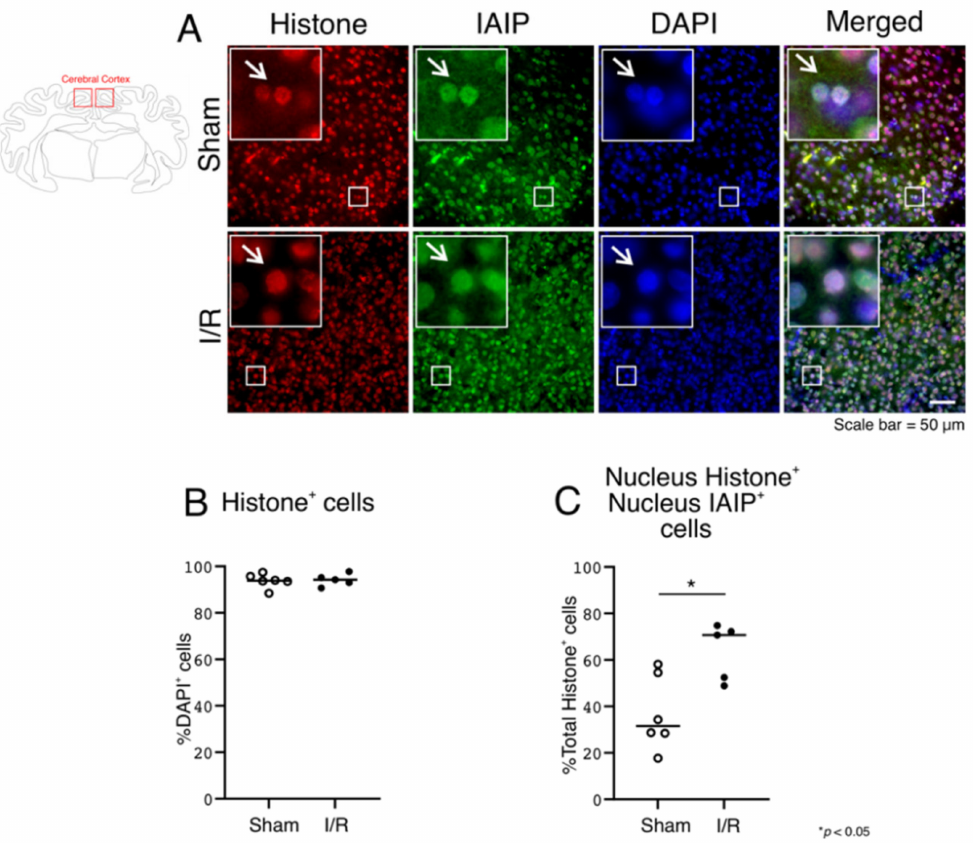
Figure 7. Co-localization of IAIPs with histones in the nucleus in the cerebral cortex. Schematic diagram of a sheep brain indicates the regions from which cerebral cortical samples were taken. ( A ) Representative images of histone (Red), IAIPs (Green), DAPI-positive cells (Blue), and merged double immunostaining in the cerebral cortex of fetal sheep in Sham and I/R groups. Magnification, 40 × . Each inset contains the extended images. Scale bar = 50 µ m. Arrows indicate the same cell. ( B ) Quantification of histone H3-positive stained cells. Histone H3-positive cells plotted as a percentage of DAPI-positive cells on the y -axis for Sham (open circles) and I/R (closed circles) groups on the x -axis. ( C ) Quantification of IAIP-positive Histone H3 nuclei. IAIP-positive histone H3-positive cells plotted on the y -axis for nuclear compartment for Sham (open circles) and I/R (closed circles) groups plotted on the x -axis. Values median and scattergrams. * p < 0.0133